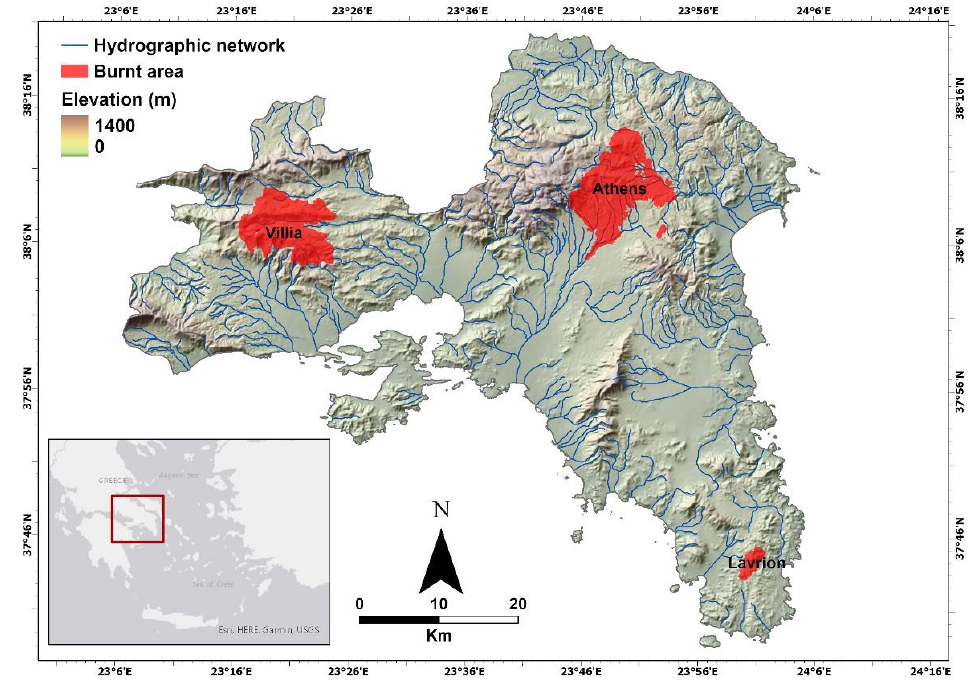
Figure 2. The fire affected areas host a well-developed drainage system, part of which are draining urban areas. Two main hydrographic systems exist in the wider area of Varimpompi fire affected area, Oinoi river, which flows towards Marathon, and Kifissos river, which flows towards western suburbs of Attica.